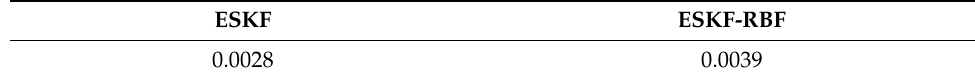
Table 6. Execution time